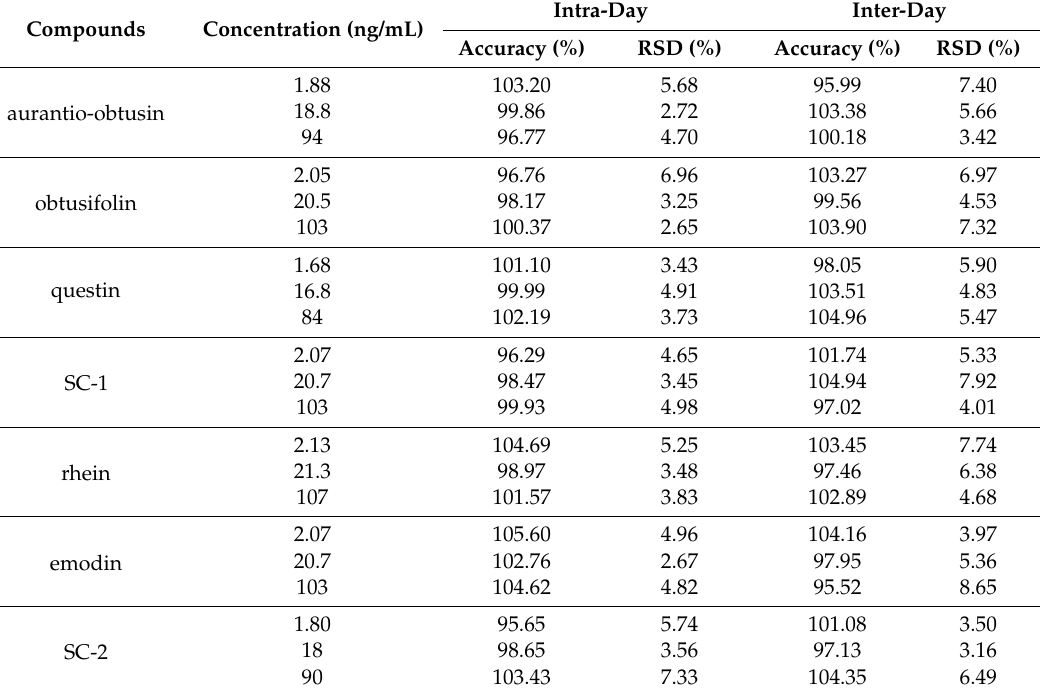
Table 2. Precision and accuracy of the seven analytes in rat plasma ( n = 3 days, 6 replicates per day).